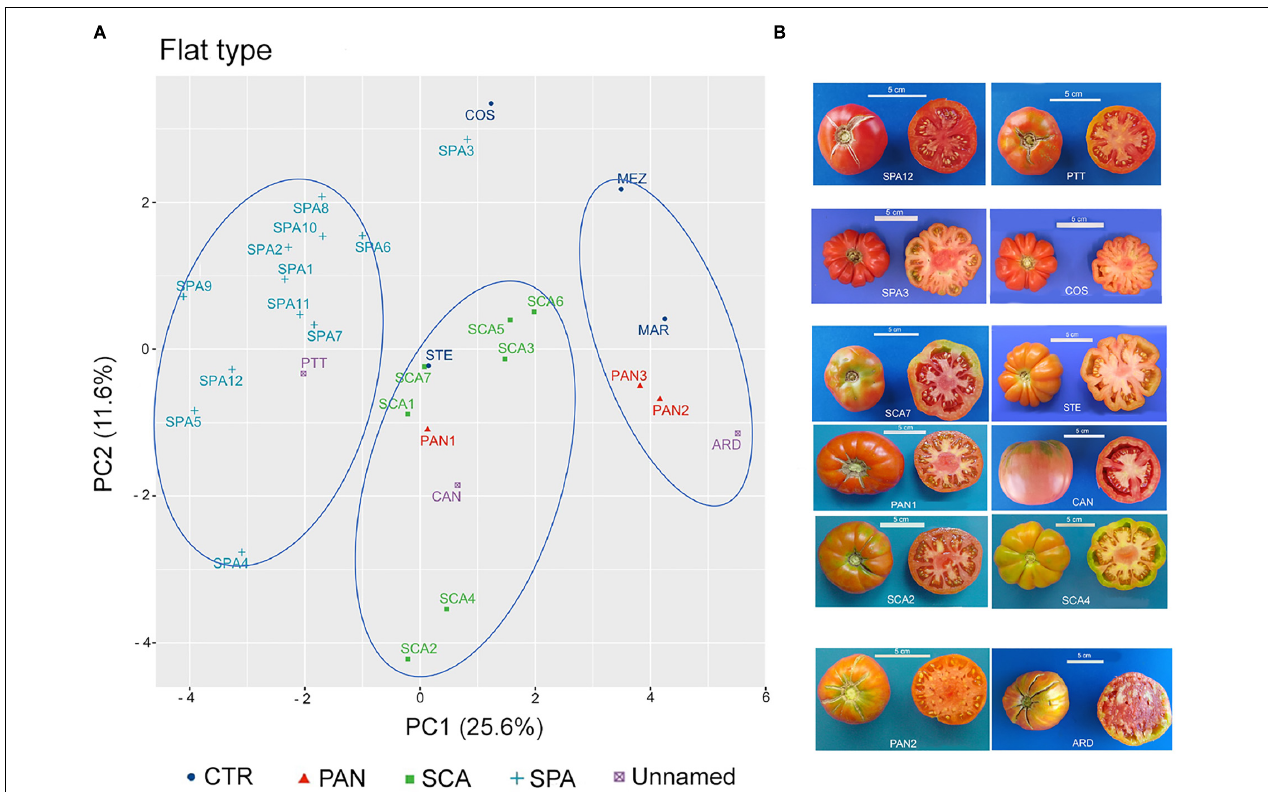
FIGURE 6 | Phenotypic variability of the 29 tomato genotypes included in the flat-type group. (A) Scatter plot of the first (PC1) and second (PC2) principal component, showing the variation in 15 quantitative and ten qualitative vegetative and reproductive traits in the 29 accessions included in the flat-type group. Accessions are represented by different colored symbols as indicated in the legend; abbreviations are listed in Supplementary Table 1 . (B) Pictures of whole and cross-sectioned fruits of representative accessions included in each of the three clusters identified by the PCA. Scale bar is 5